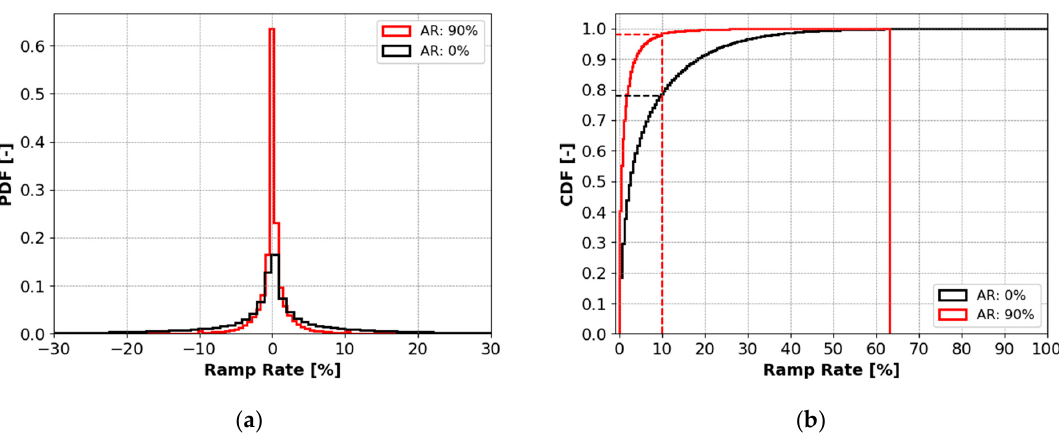
Figure 14. Abatement ratio 90% vs. 0%: ( a ) PDF ( b ) CDF.